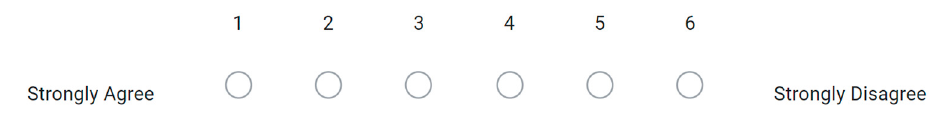
Figure 2. Likert Scale that was implemented for the VAX subscales.